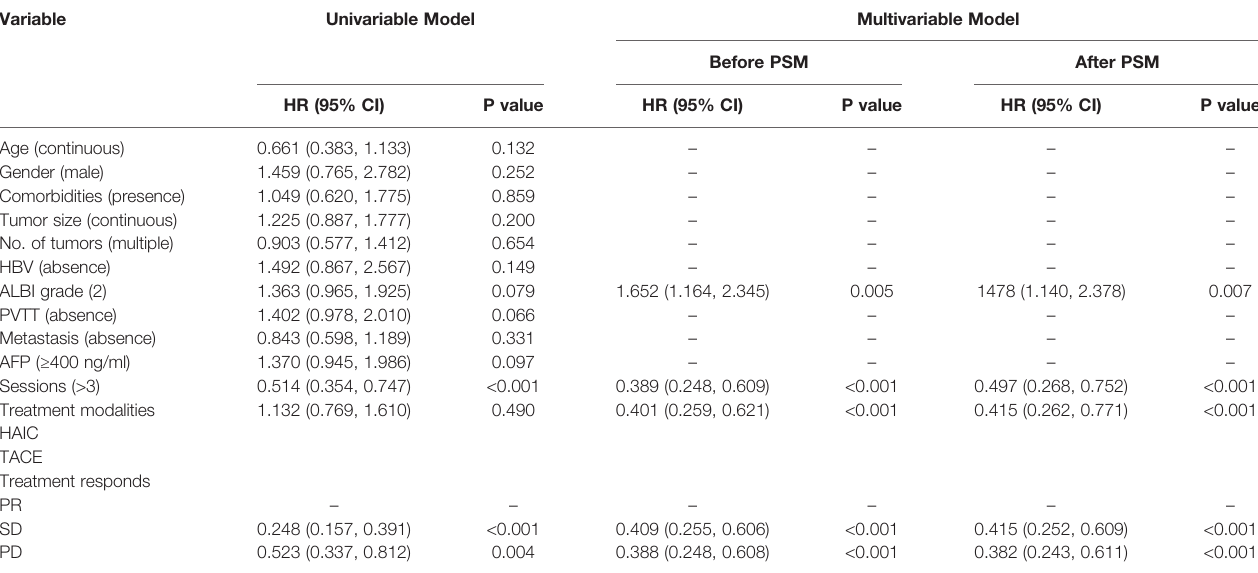
TABLE 4 | Results of the univariable and multivariable Cox regression model with regard to